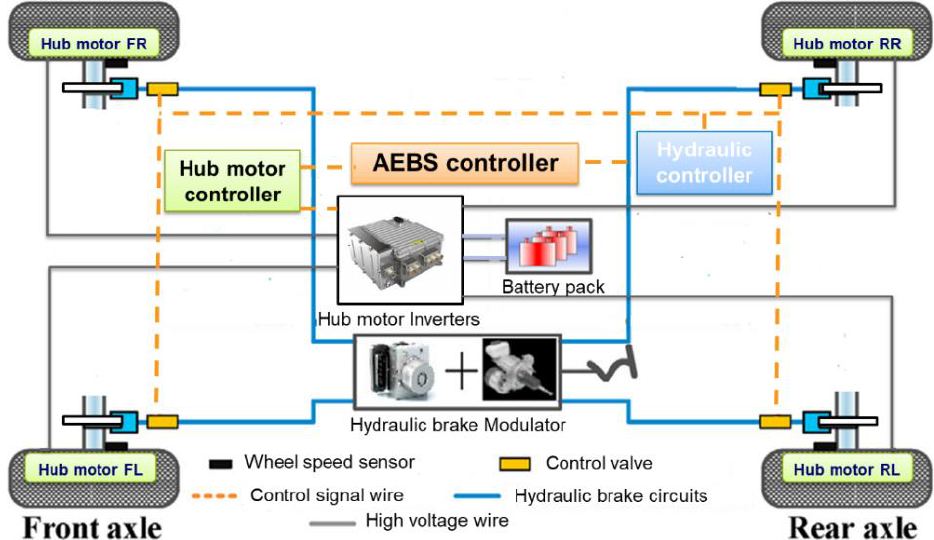
Figure 1. A novel braking architecture for 4WD BEV.